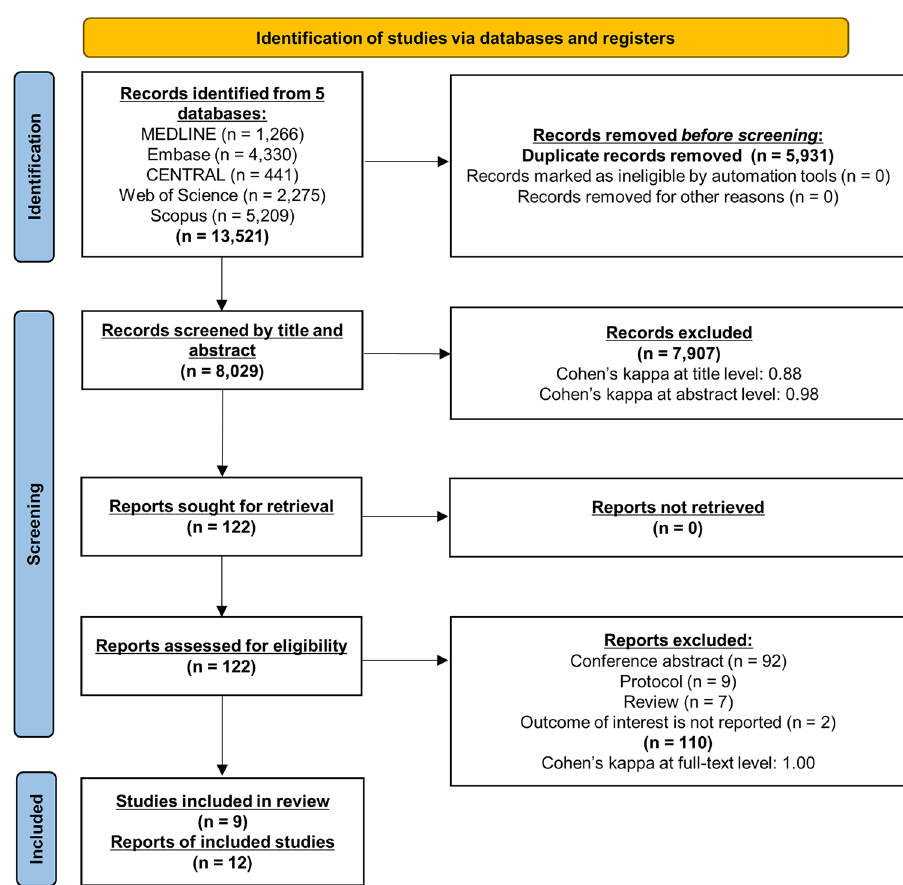
Figure 1. PRISMA Flow Diagram. This diagram details our systematic search and selection